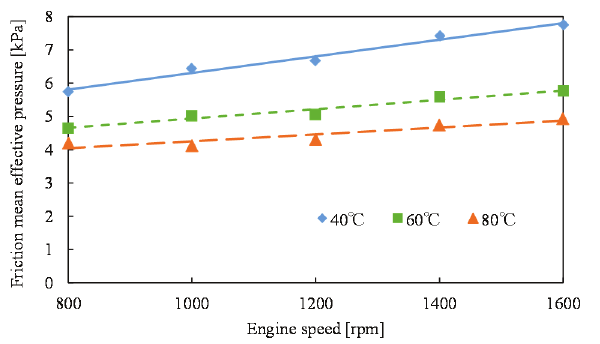
Fig. 7. Friction mean effective pressure (FMEP) with three-ring set